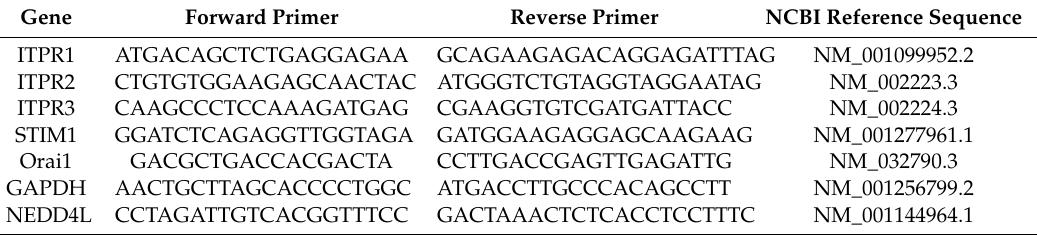
Table 2. Primer sequences for quantitative real-time